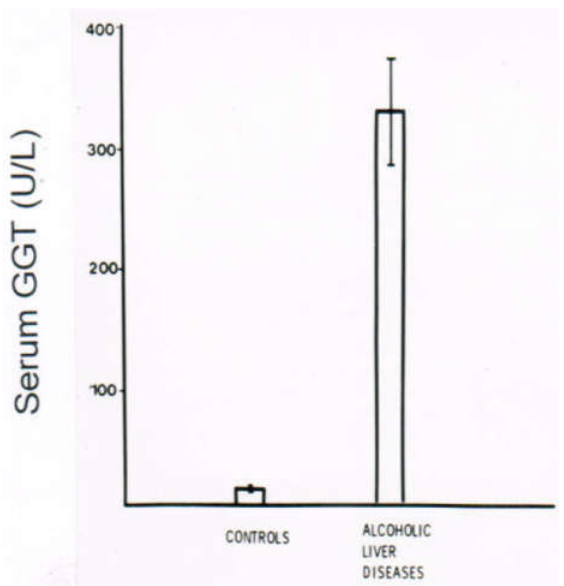
Figure 14. Serum gamma‐glutamyltransferase (GGT) activity in alcoholic liver diseases. Patients with an alcoholic liver disease show increased serum GGT activities as compared to a control group lacking a previous history of alcohol abuse and with normal liver tests.